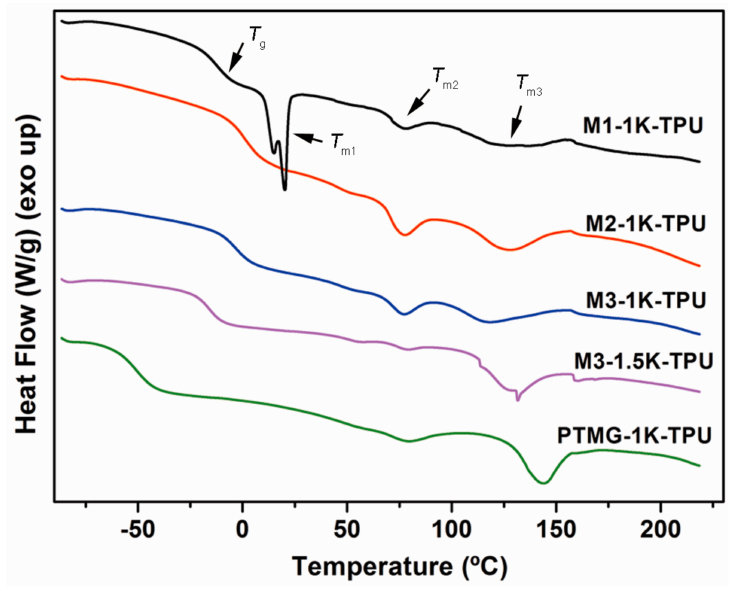
Figure 6. DSC curves of TPUs (first